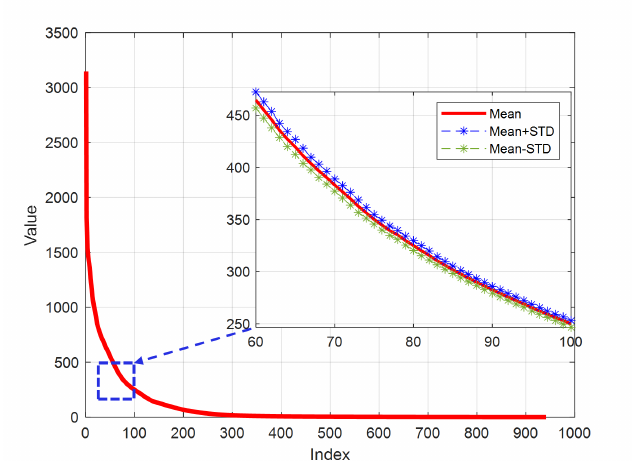
Figure 4. The mean ± standard deviation of singular values of A .